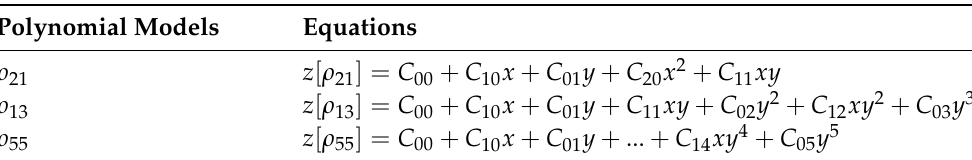
Table 2. Examples of polynomial models for surfaces. Polynomial Models